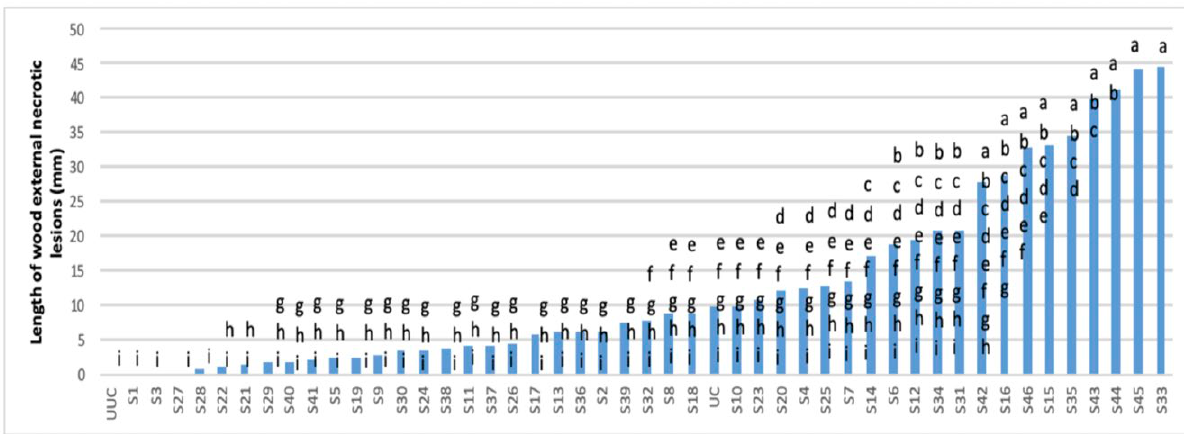
Figure 1. Mean wood canker lesion lengths (mm) in grapevine cuttings following inoculation with 46 different bacterium strains and co- inoculation with Neofusicoccum parvum in the first bioassay. Grapevine cutting stems (cv. Cabernet Sauvignon) were co-inoculated with bacteria and N. parvum before incubation in an open greenhouse for 4 months. The uninfected controls (UC) were inoculated only with N. parvum . The uninoculated, uninfected control (UUC) was not inoculated with the fungus and not treated with bacteria. Each value repre- sents the mean of 16 or 11 cuttings, depending on the bioassay (Haidar e t al., 2016a). Means accompanied by the same letter are not signifi- cantly different ( P = 0.05; Newman and Keuls’ test after ANOVA).